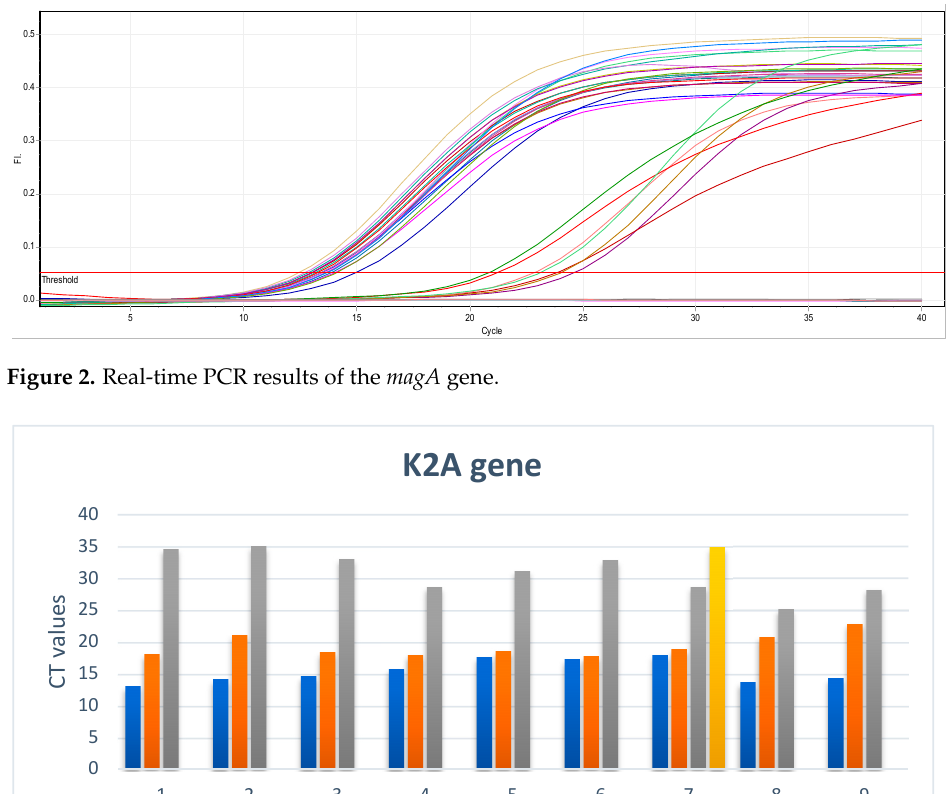
Figure 1. magA gene expression in Klebsiella pneumoniae isolates treated with different concentrations of ZnO NPs.